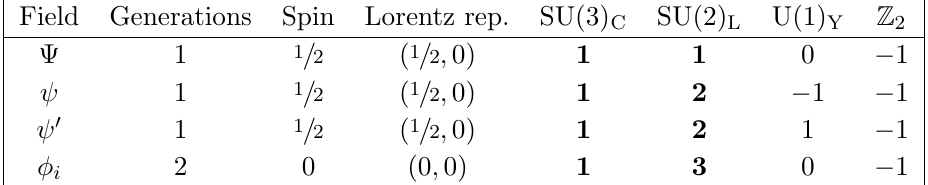
Table 1 . New (cid:12)elds and their quantum numbers in the model T1-3-B with (cid:11) =